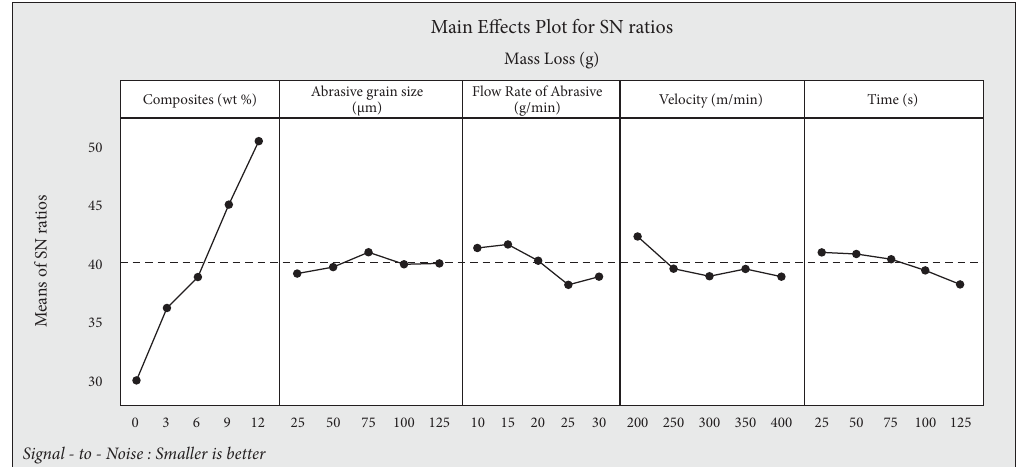
Figure 5: Main efects plot for means.